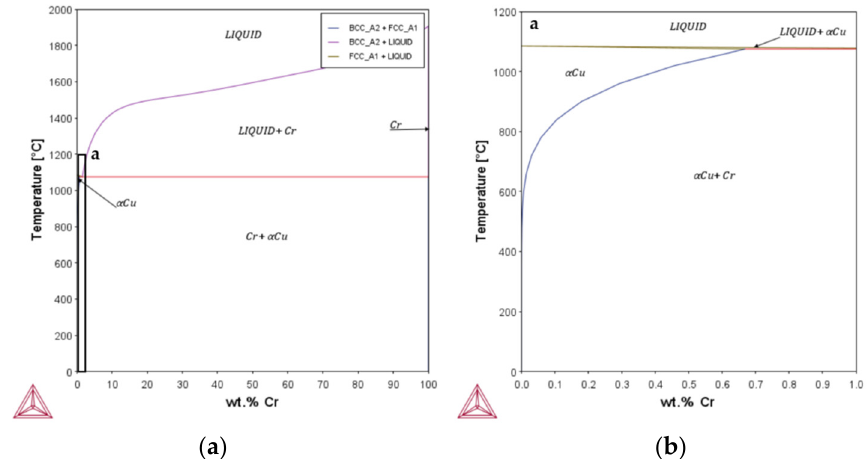
Figure A1. System Cu-Cr: ( a ) overall; ( b ) magnification of the copper-rich area (detail a).